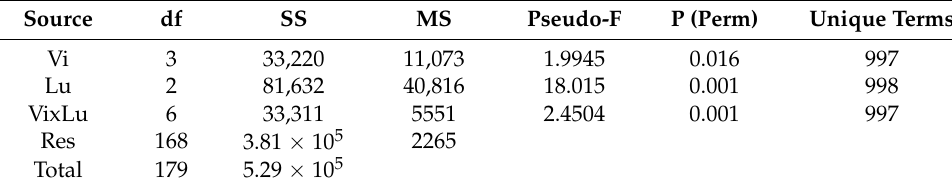
Table 2. PERMANOVA results of species richness between areas and study villages.